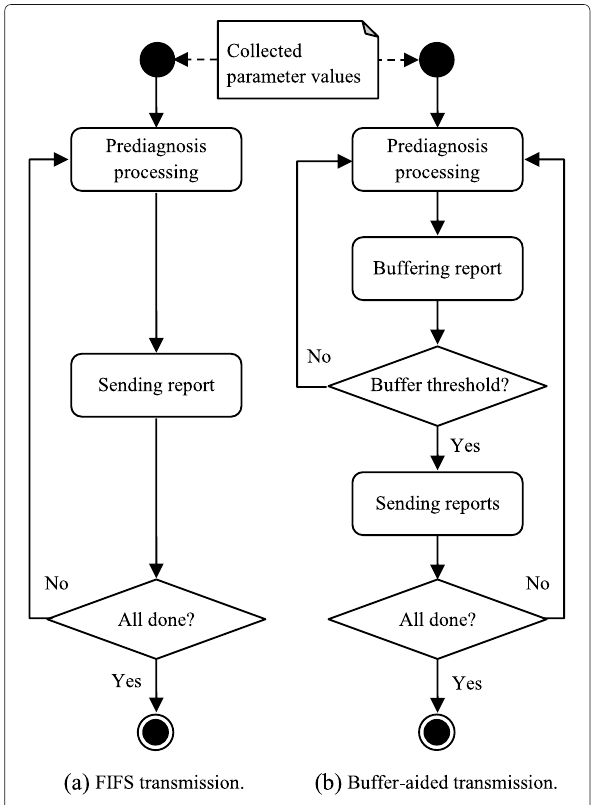
Fig. 5 Activity diagram of the two mechanisms for transmitting prediagnosis